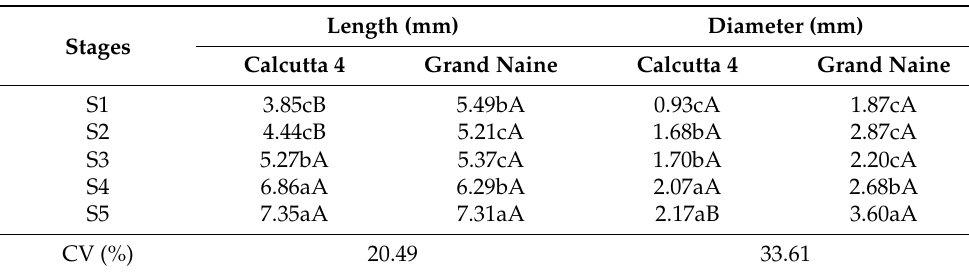
Table 1. Morphometric characteristics of septal nectary length and diameter of Calcutta 4 and Grand Naine cultivar at the five stages of floral development.